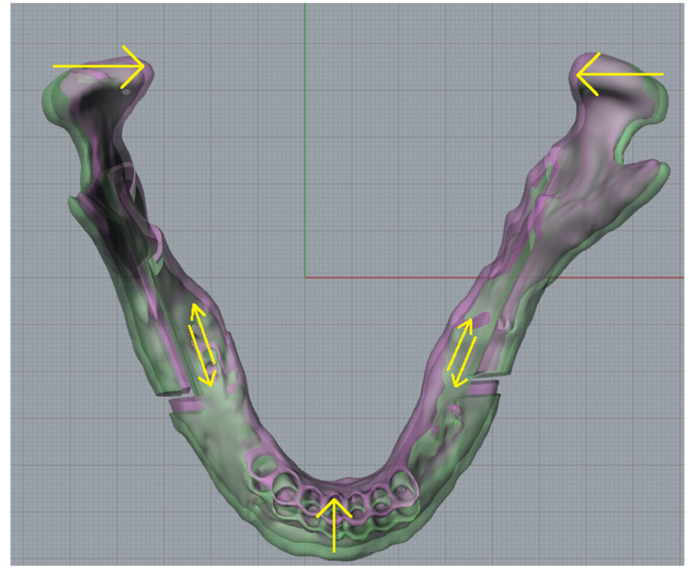
Figure 3. Telescopic effect on the